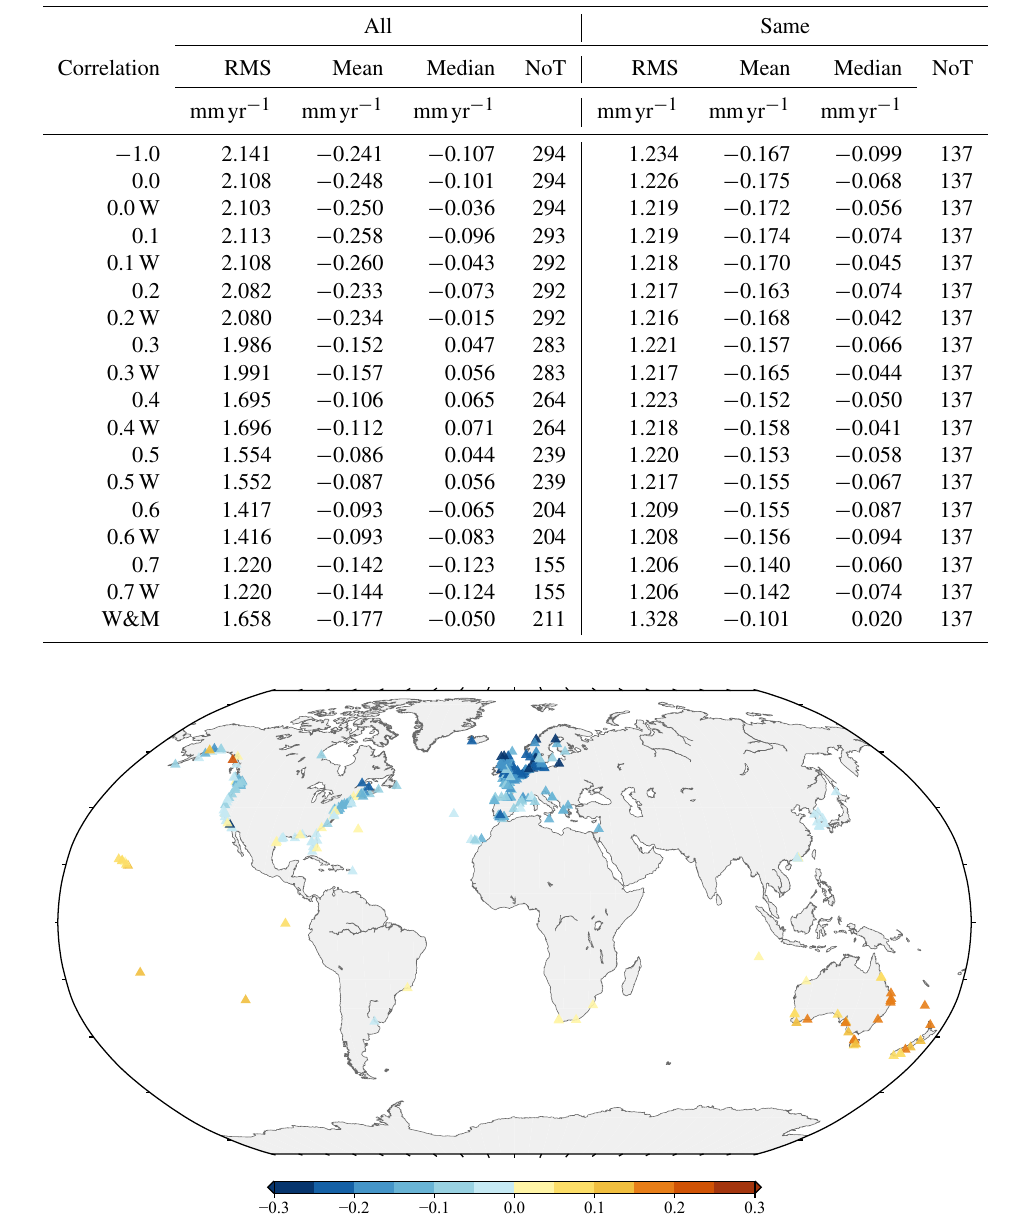
Figure 9. Trend differences (mm yr − 1 ) between the GNSS and ALT–TG time spans induced by nonlinear VLM due to present-day mass